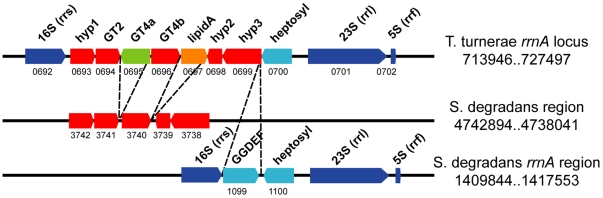
Anomalous organization of ribosomal operon A (rrnA) in T. turnerae and S. degradans.One of three ribosomal RNA operons (rrnA) in the T. turnerae genome displays unusual organization. In this operon, the small (rrs) and large (rrl) subunit ribosomal RNA genes are separated by protein coding genes in both T. turnerae and S. degradans rather than by internal transcribed spacers (ITS) as in most bacteria. All intervening genes have homologues in both genomes. The common location of homologous heptosyltransferase genes in both genomes suggests at least one common ancestral insertion. Ribosomal rRNA genes are depicted in blue. Open reading frames (red, green, orange, and light blue) have been colored to distinguish homologous genes. Dotted lines mark indel boundaries. Chromosomal locus coordinates are indicated to the right of each depicted genome region and unique locus tag numbers are indicated beneath each locus without the preceding GenBank prefixes (TERTU_ for T.turnerae or Sde_ for S. degradans, respectively).